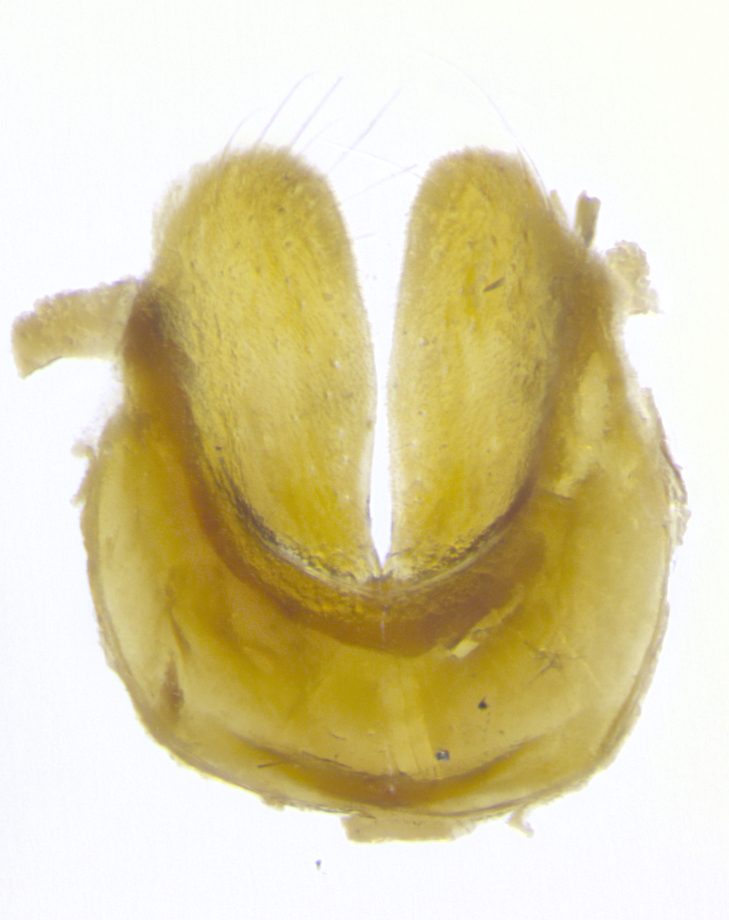
Sternite 5, ventral view.